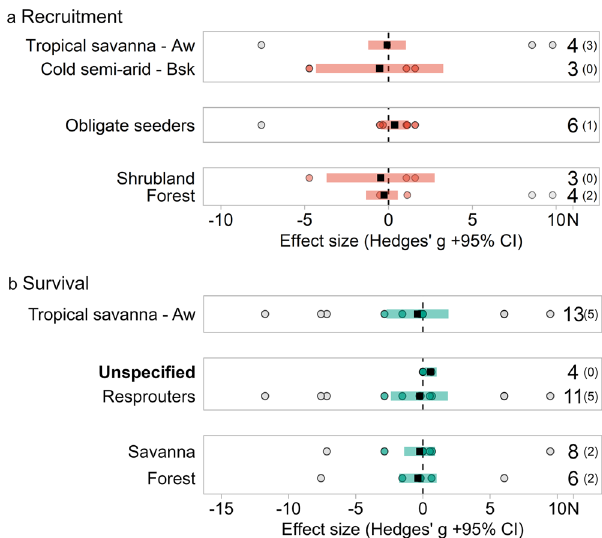
Fig. 3 Early season fi res increase post- fi re reproduction relative to late season fi res. Results of subgroup meta-analysis investigating the effects of climate type, plant functional group and vegetation type for comparisons of a recruitment and b survival between early and late season fi res. Modelled mean effects and 95% con fi dence intervals around the mean presented. Negative Hedges ’ g -values represent increased effects of late season fi res relative to early season fi res. Positive Hedges ’ g -values represent increased effects of early season fi res relative to late season fi res, coloured points represent studies within 95% CI of pooled effect size estimate and non- coloured points have been identi fi ed as outliers and excluded from analysis. N represents the sample size in each of the subgroup comparisons, numbers within parenthesis adjacent to N numbers indicate number of outliers that were identi fi ed within each analysis. Bold text indicates subgroups with signi fi cant effects. Comparison sample size for reproduction was too small (<3) and therefore was not included in this subgroup analysis. Studies where species responses were reported without reporting response traits we characterised as “ unspeci fi ed ” .